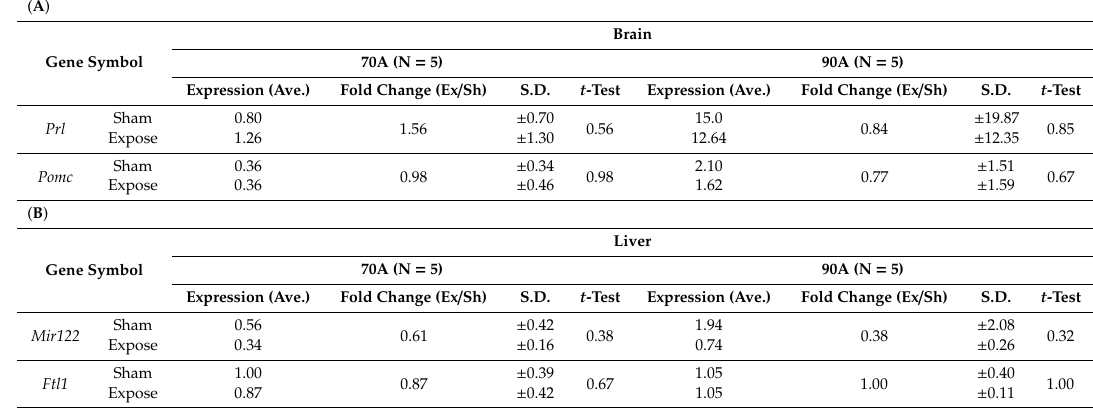
Table 3. Relative transcript expression levels analyzed with real time RT-PCR in the ( A ) brain and ( B )